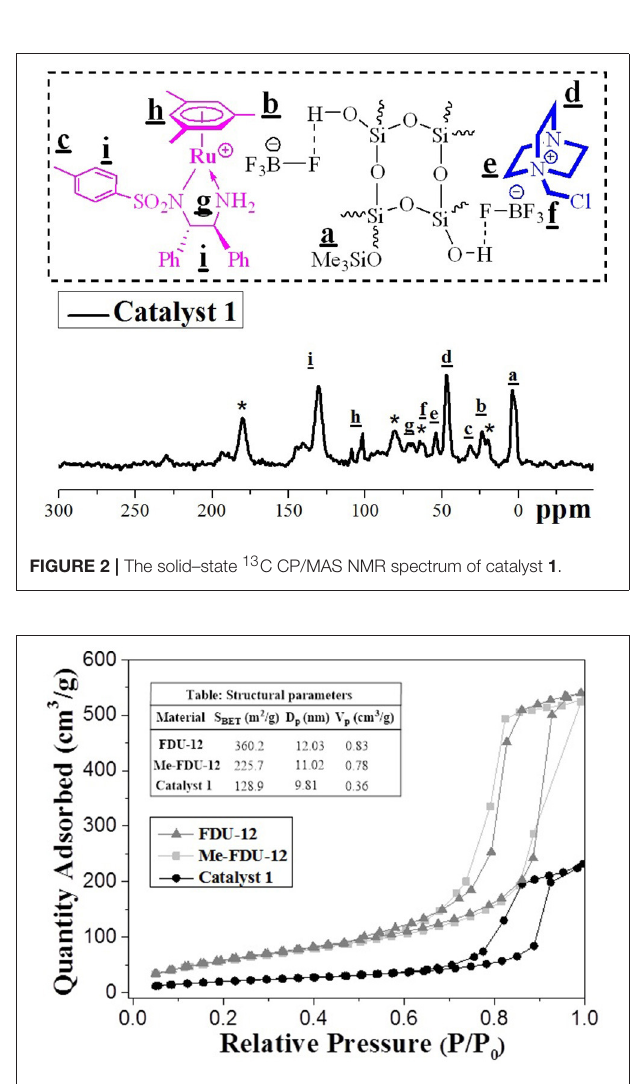
FIGURE 3 | Nitrogen adsorption–desorption isotherms of Me–FDU − 12 and catalyst 1 .